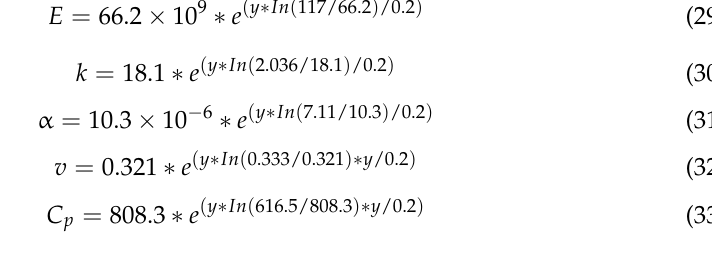
Table 1. Thermophysical parameters of